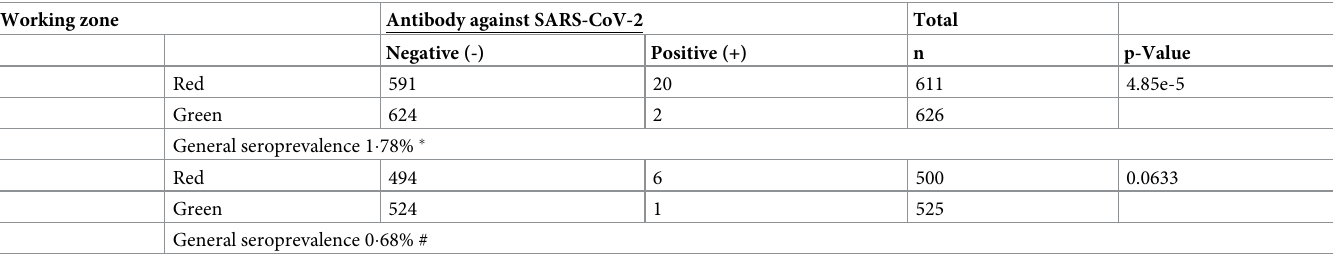
Table 1. Risk comparison between red zone and green zone workers in Shiga Prefecture. Working